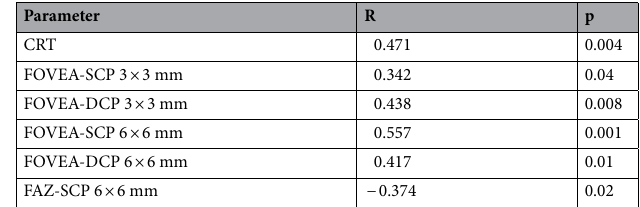
Table 4. Significant associations (Pearson coefficient) between OCT-A parameters and the number of hypotensive episodes during follow-up. CRT central retinal thickness, FAZ foveal avascular zone, DCP deep capillary plexus, SCP superficial capillary